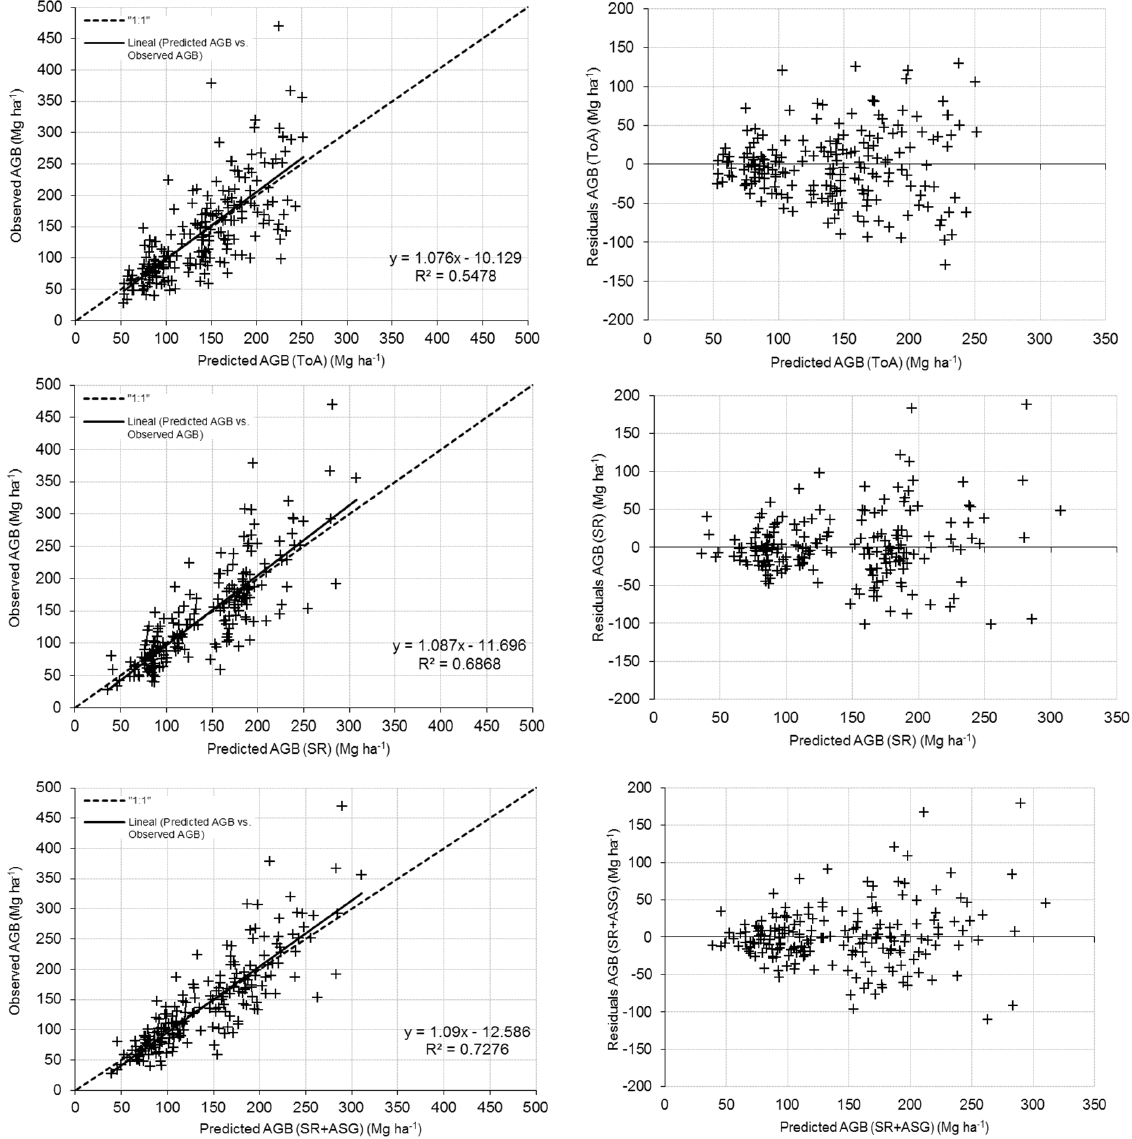
Figure 3. Graphs showing the distribution of the residuals and of the observed AGB values with ToA (upper), SR (middle) and SR with ASG variables (bottom).